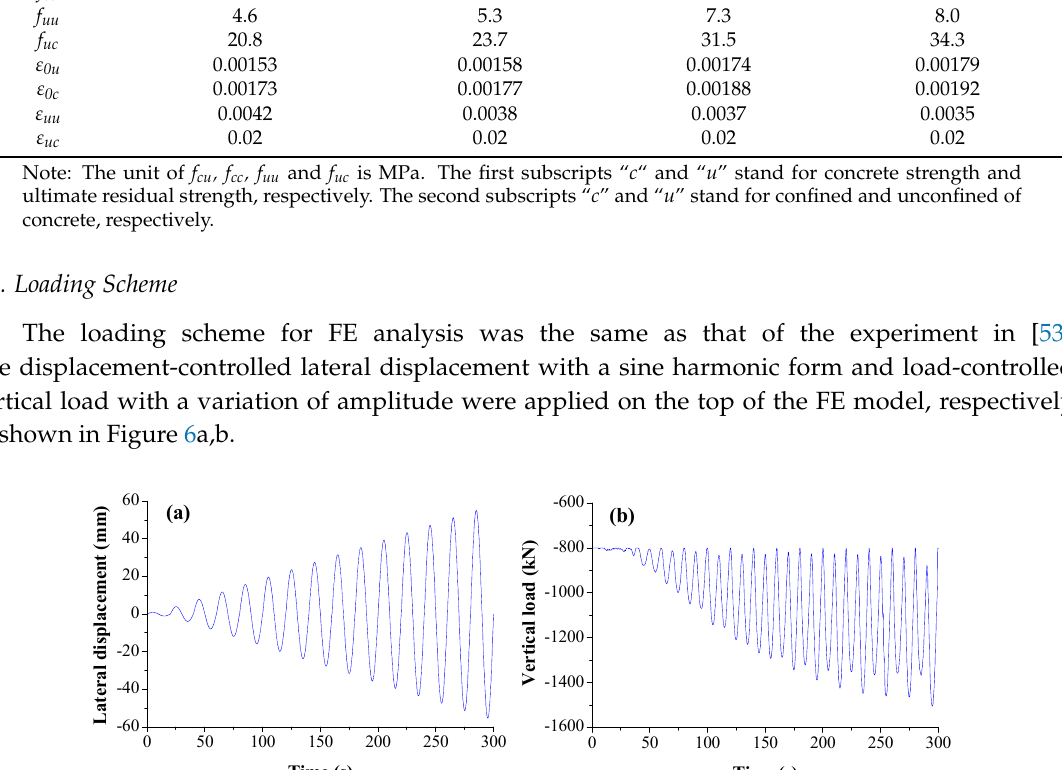
Table 1. Parameters of concrete constitutive relationship.